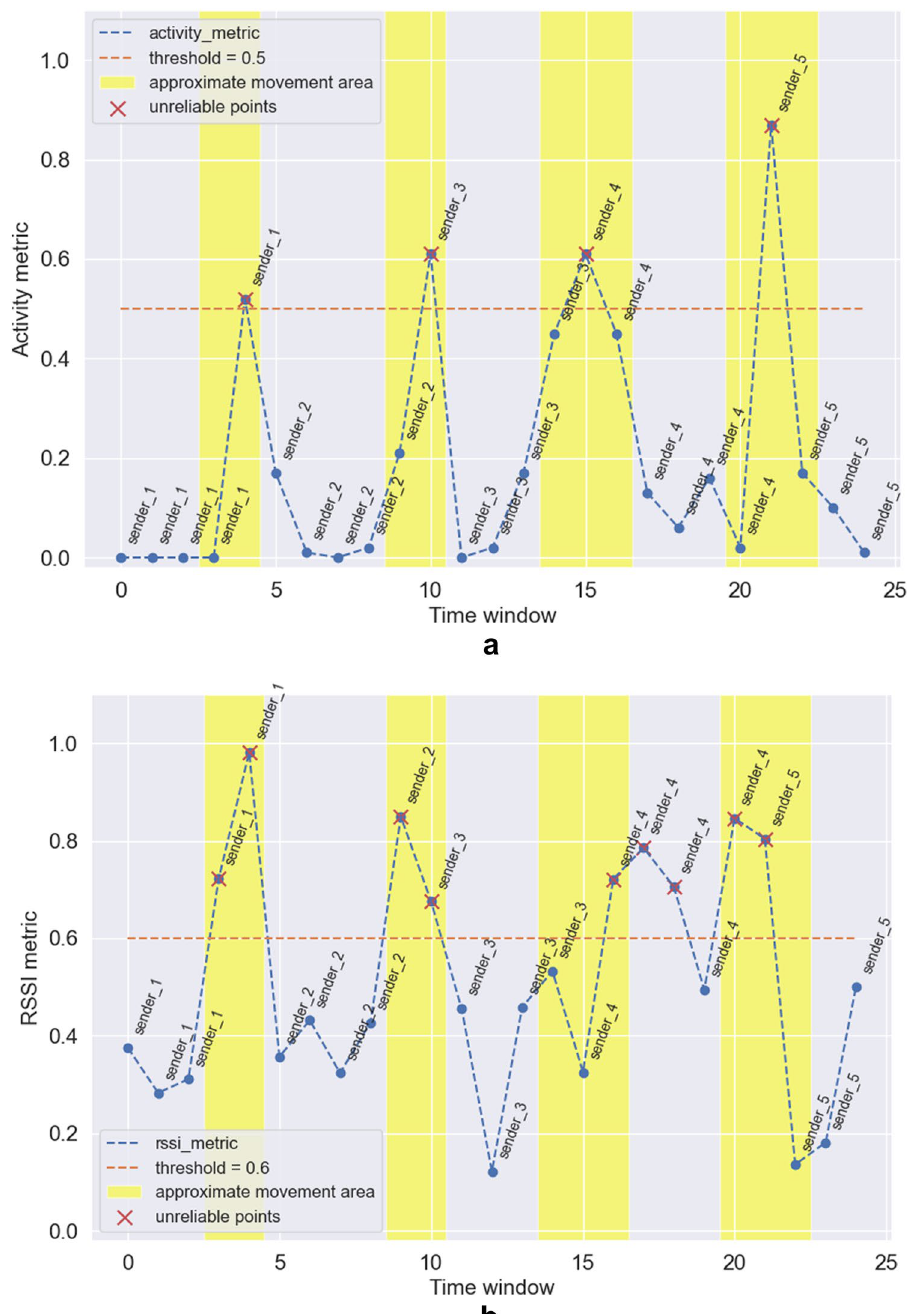
Figure 6. Filtering of unreliable proximity estimation results based on base metrics: ( a ) activity metric; ( b ) RSSI